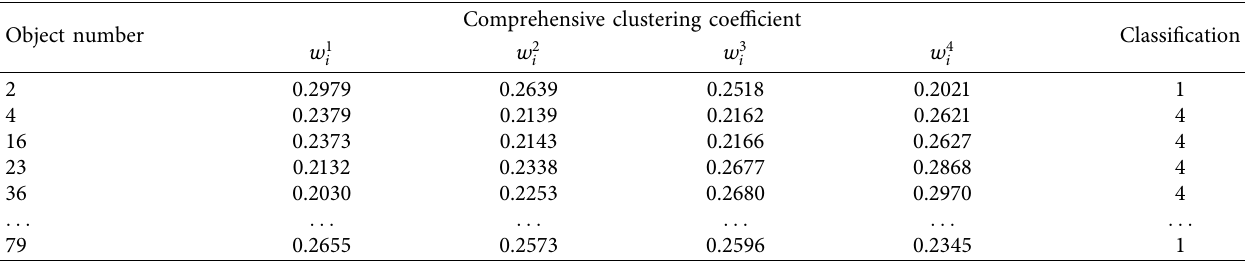
Table 4: Results of the comprehensive clustering coefficient and its